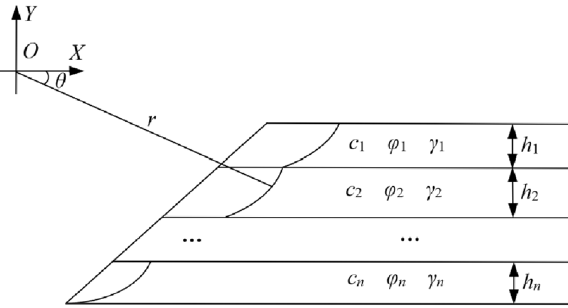
Figure 1. Failure mechanism of horizontal stratified